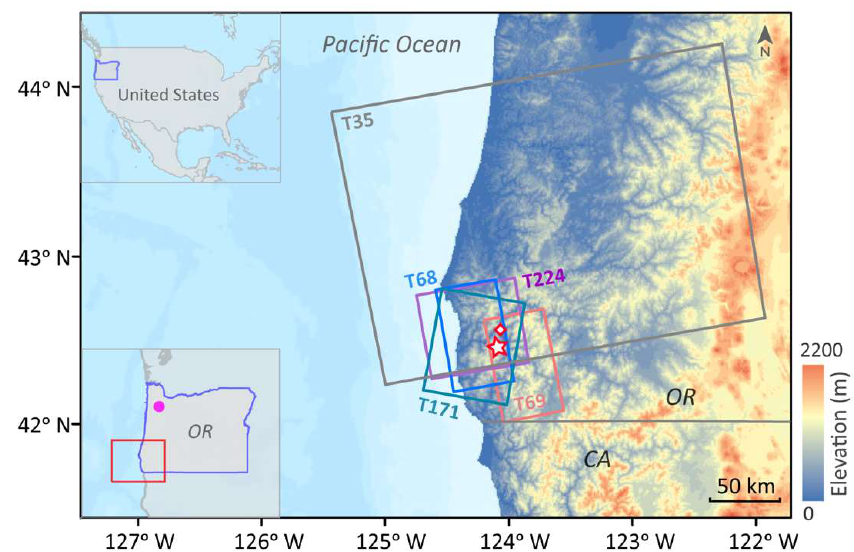
Figure 1. Geographical location of the Lawson Creek landslide and synthetic aperture radar (SAR) data used in this study. The landslide (marked with a red star) is located in Curry county, southwestern Oregon, about 27 km inland from the Pacific Ocean. The location of Oregon is outlined in blue in both scaled-down (top-left corner) and scaled-up (bottom-left corner) maps. The red box at the bottom-left-corner figure represents geographical location of the whole Figure 1, and the magenta point represents a ground reference site for soil-moisture measurements (Miller Woods station). The red diamond near the landslide site represents a precipitation collection site (Agness station). SAR imagery covering the landslide is denoted with colored rectangular boxes annotated by track names in corresponding colors. The background shaded relief map was accessed from U.S. Geological